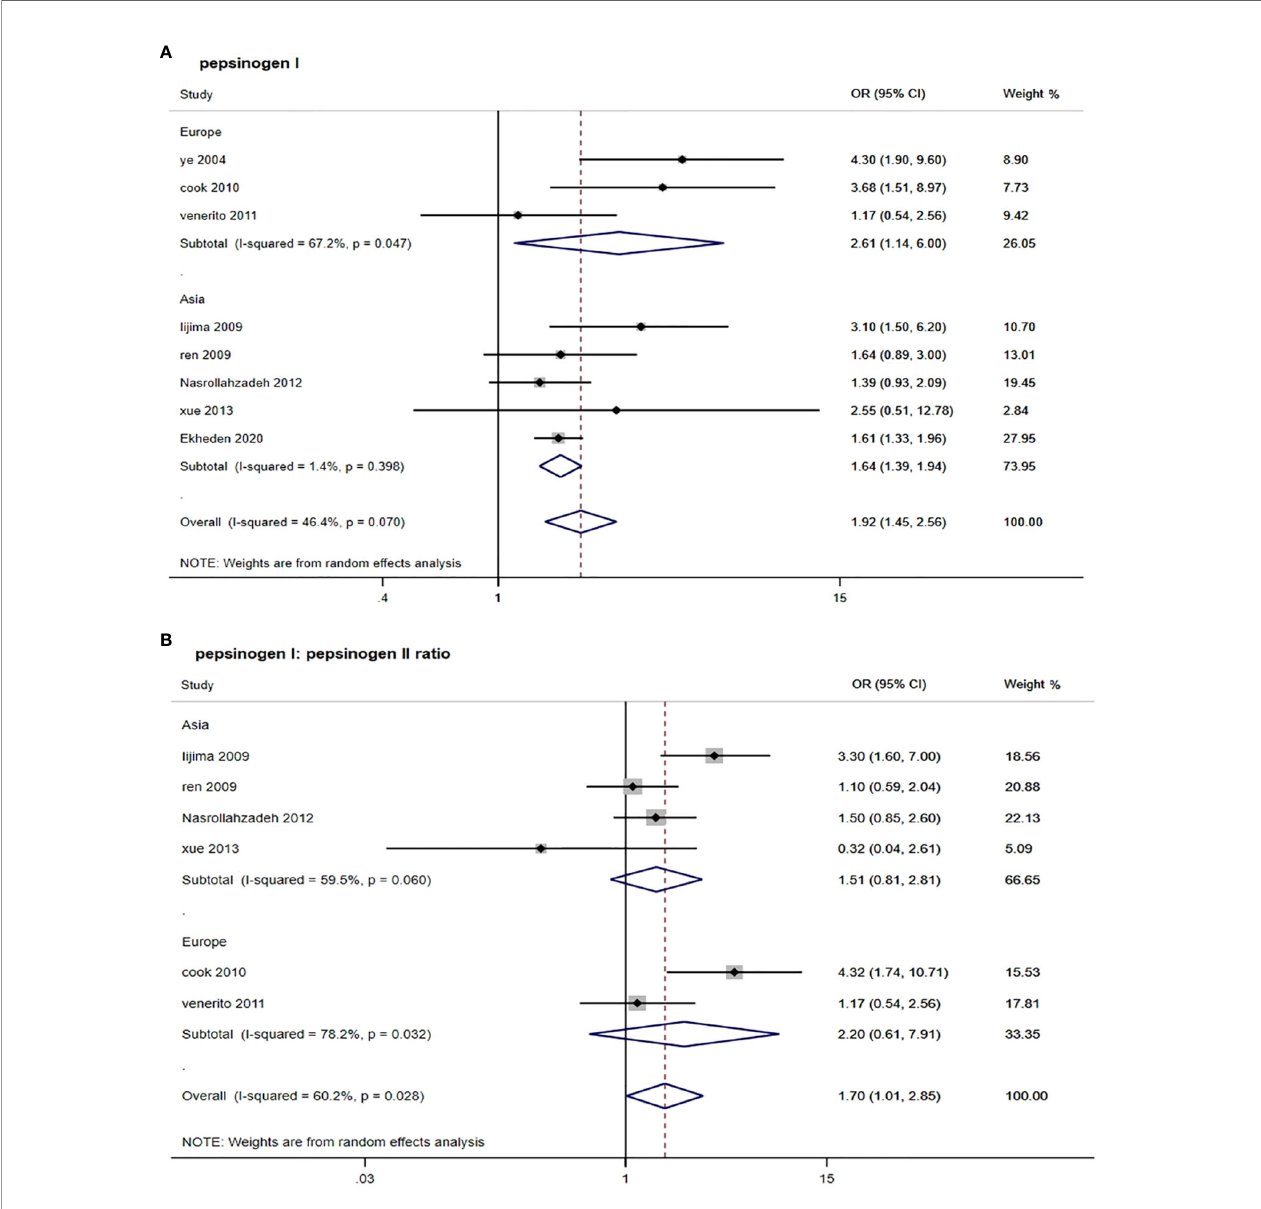
FIGURE 2 | Forest plots from random-effect meta-analysis of the association between PGI and PGR and risk of esophageal squamous cell carcinoma. (A) Pepsinogen I; (B) pepsinogen I: pepsinogen II ratio. PGI, pepsinogen I; PGR, pepsinogen I: pepsinogen II ratio; OR, odds ratio; CI, con fi dence